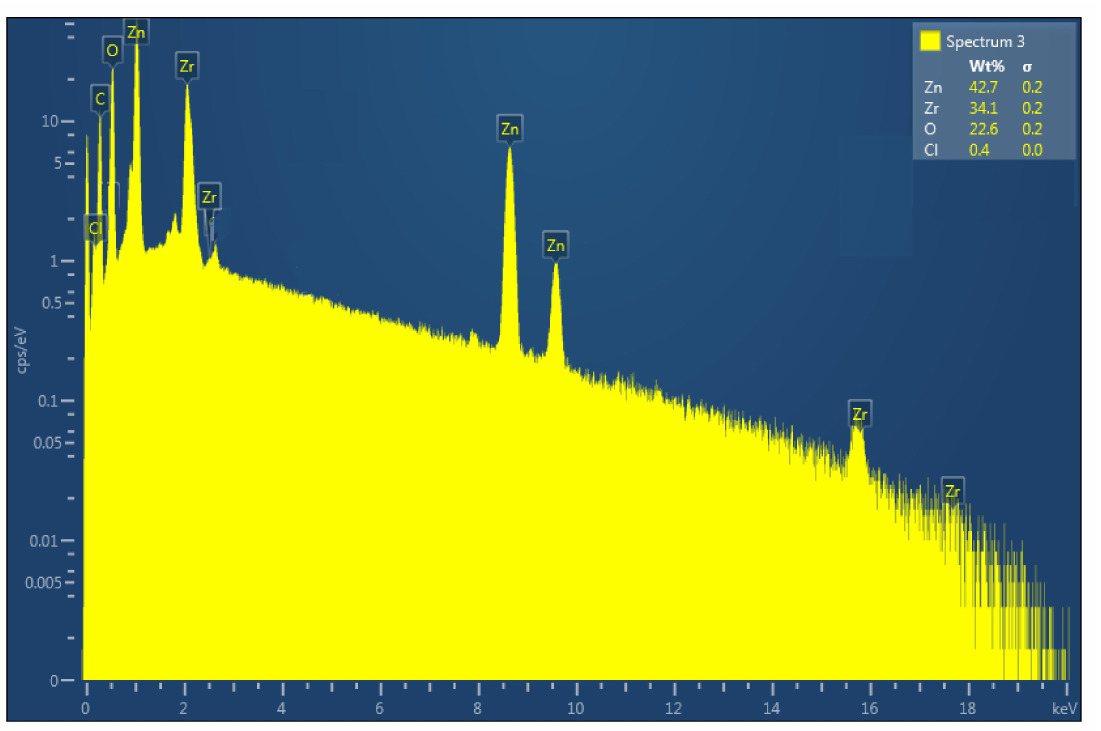
Figure 5. EDX spectrum of ZnO-ZrO 2 NC calcined at 100 ◦